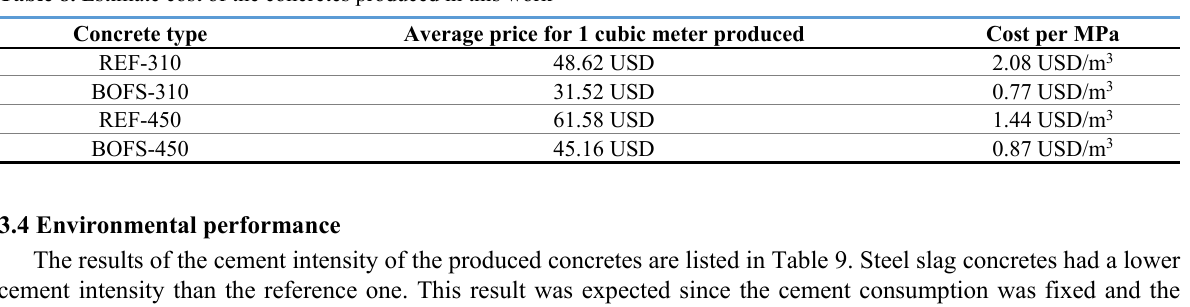
Table 8. Estimate cost of the concretes produced in this work